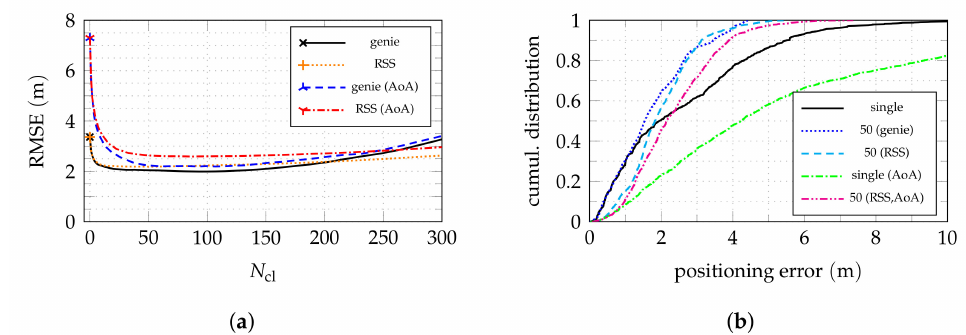
Figure 10. Effects of clustering on overall positioning root-mean-square error (RMSE) and error distribution for single nodes. A cluster size of N cl = 0 (indicated by a marker) means only the node by itself. All anchors active. ( a ) RMSE over cluster size for genie-aided and RSS-based clustering. The TDoA+AoA (not explicitly indicated) and the AoA-only cases are compared. ( b ) Cumulative absolute error distribution for a single node and one fixed cluster size of N cl =